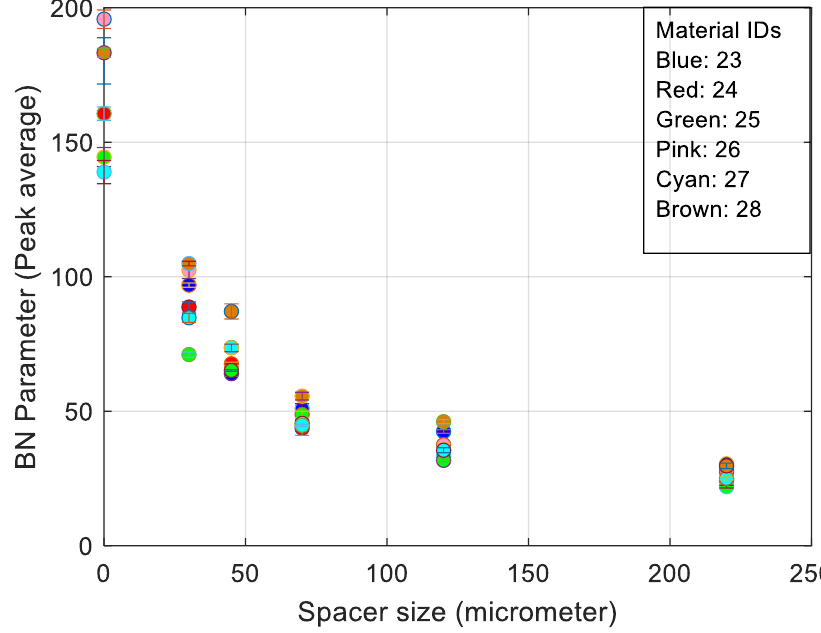
Figure 7. BN signal response, Peak Average for bottom surface in Transversal orientation.